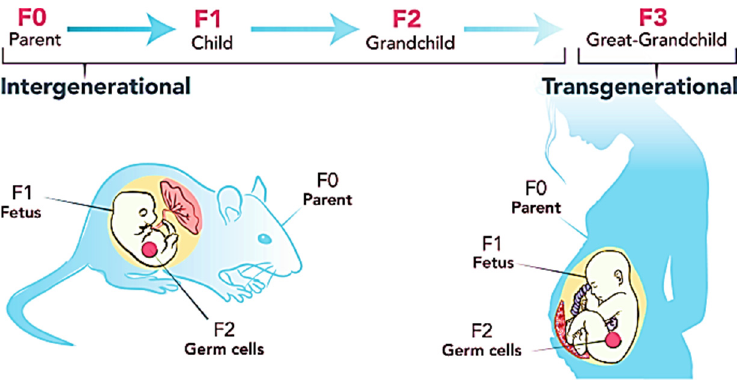
Figure 3. Transgenerational inheritance pattern of obesity. Figure reused under the permission granted by http://creativecommons.org/licenses/by/4.0/ (accessed on 21st February 2022) [82].